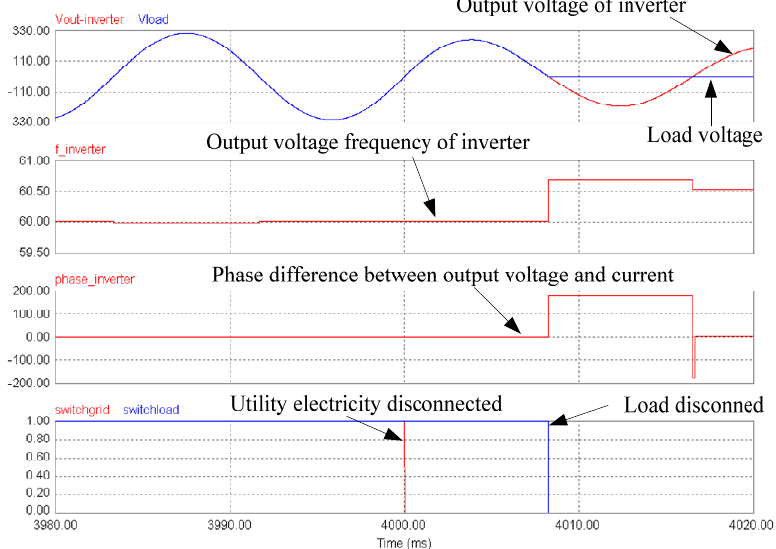
Figure 5. Diagram of simulated islanding detection when the utility grid is disconnected at second